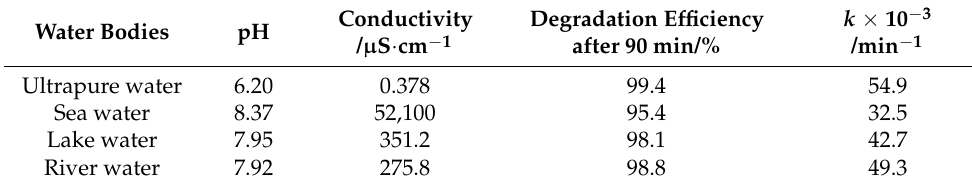
Table 4. The values of pH and conductivity of water bodies, degradation efficiency of MB,